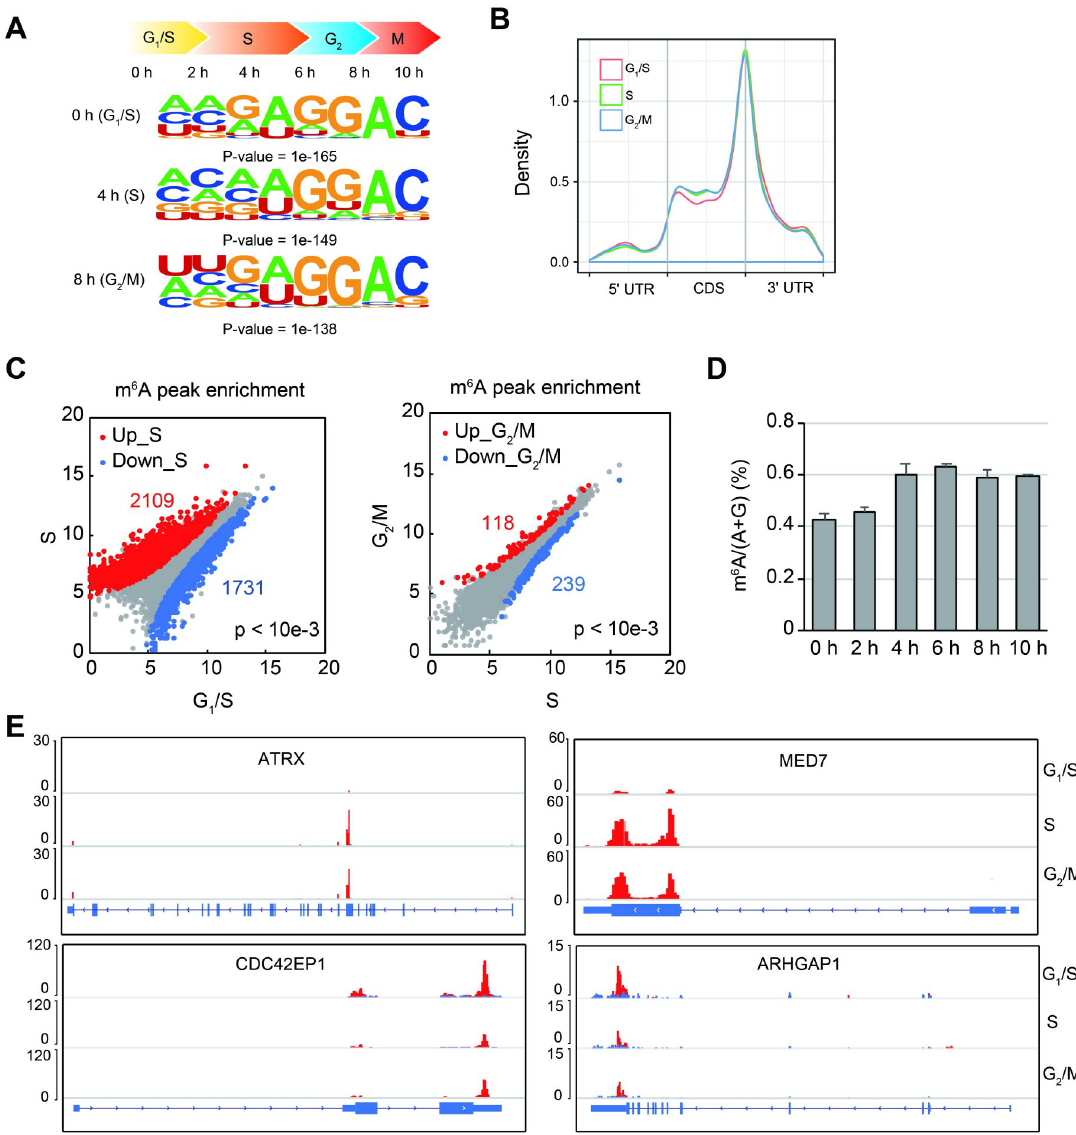
Fig 1. Dynamic transcriptomic m 6 A changes during cell cycle. (A) Enriched RNA motifs from the m 6 A MeRIP-seq data from cells at different phases of cell cycle. (B) Metagene analysis of m 6 A peak distribution on mRNAs. (C) Differential m 6 A enrichment analysis across G 1 /S, S, and G 2 /M phases of cell cycle. (D) The m 6 A levels of mRNA quantified by LC-MS/MS at different time points post G 1 /S synchronization. y-Axis indicates the ratio of m 6 A to the sum of A and G. (E) Examples of genes with dynamic m 6 A modification on mRNAs. ATRX and MED7 m 6 A peak enrichment increases at S phase compared with G 1 /S and are related to DNA duplex unwinding and Pol II transcription, respectively. m 6 A peak enrichment of CDC42EP1 and ARHGAP1 reduces at S phase, which are related to Rho protein signaling or GTPase activity. Blue and red bars indicate the input and IP read coverages, respectively. Underlying data for this figure can be found in S1 Data. ARHGAP1, Rho GTPase Activating Protein 1; ATRX, alpha thalassemia/mental retardation syndrome X-linked; CDC42EP1, CDC42 Effector Protein 1; CDS, coding sequence; IP, immunoprecipitation; LC-MS/MS, liquid chromatography–tandem mass spectrometry; MED7, Mediator Complex Subunit 7; m 6 A, N 6 -methyladenosine; MeRIP-seq, methylated RNA immunoprecipitation sequencing; Pol II, RNA polymerase II; UTR, untranslated region.